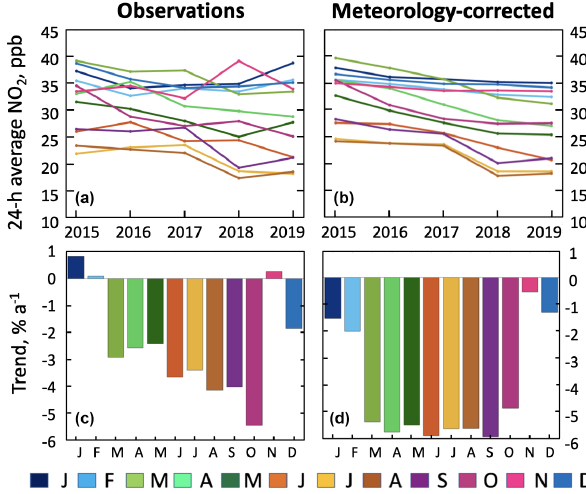
Figure 5. The 2015–2019 trends in monthly 90th percentile MDA8 ozone averaged across the 79 AirKorea sites in the Seoul metropoli- tan area (SMA). Panels (a) and (c) show the observed trends for individual months, and panels (b) and (d) show meteorology- corrected trends. Panels (c) and (d) show the 2015–2019 slopes for individual months obtained by ordinary least-squares regressions of the data in panels (a) and (b) .